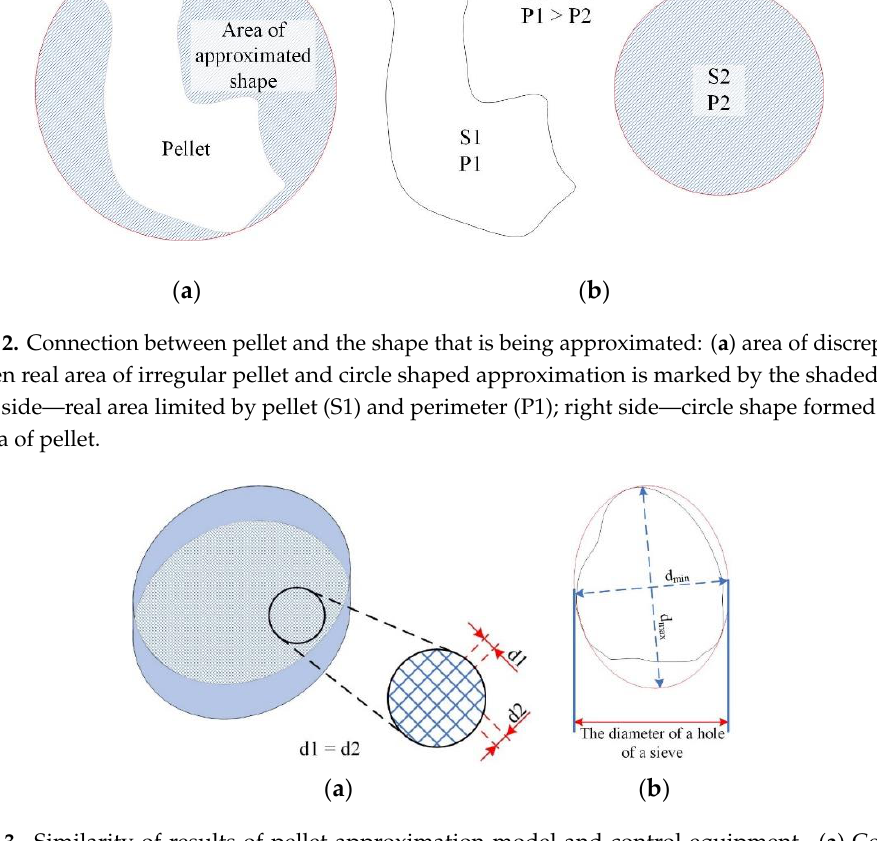
Figure 3. Similarity of results of pellet approximation model and control equipment. ( a ) Control measuring equipment consisting of a set of sieves with different diameter holes; ( b ) the width of pellet approximation shape matches the diameter of a hole of a sieve.